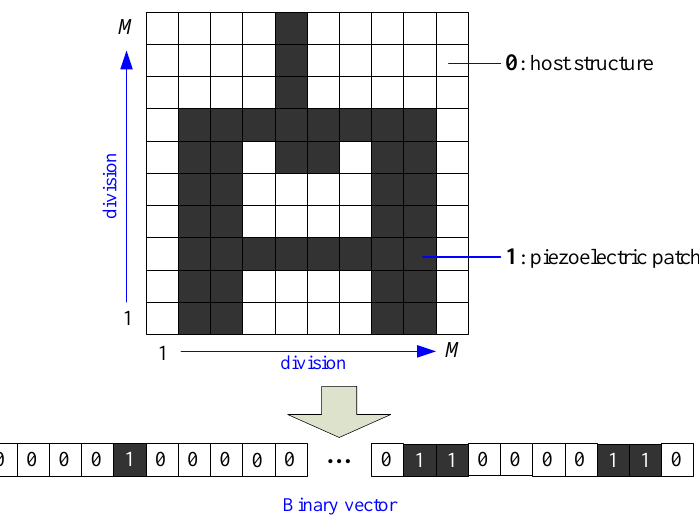
Figure 2. Binary representative of the PMPIC unit cell.